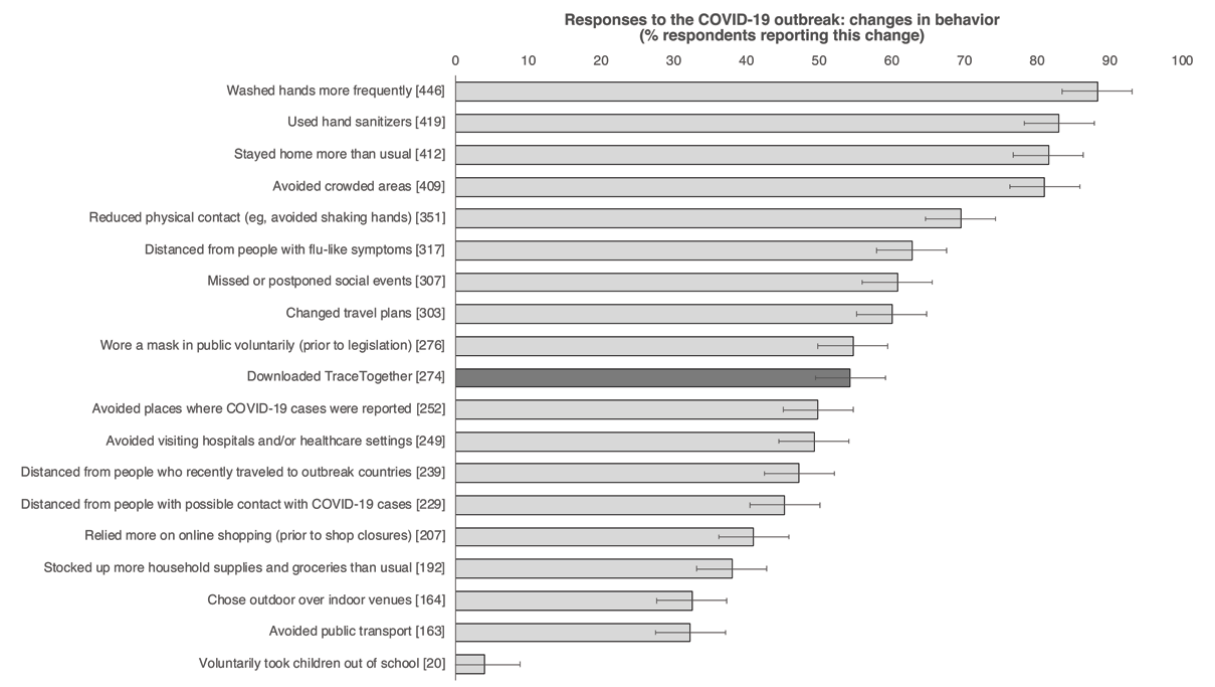
Figure 1. Self-reported behavioral modifications , other than downloading TraceTogether, among the study participants undertaken in response to the COVID-19 outbreak in Singapore. Error bars=95% CI. Numbers in brackets represent the total number of respondents who reported the behavioral